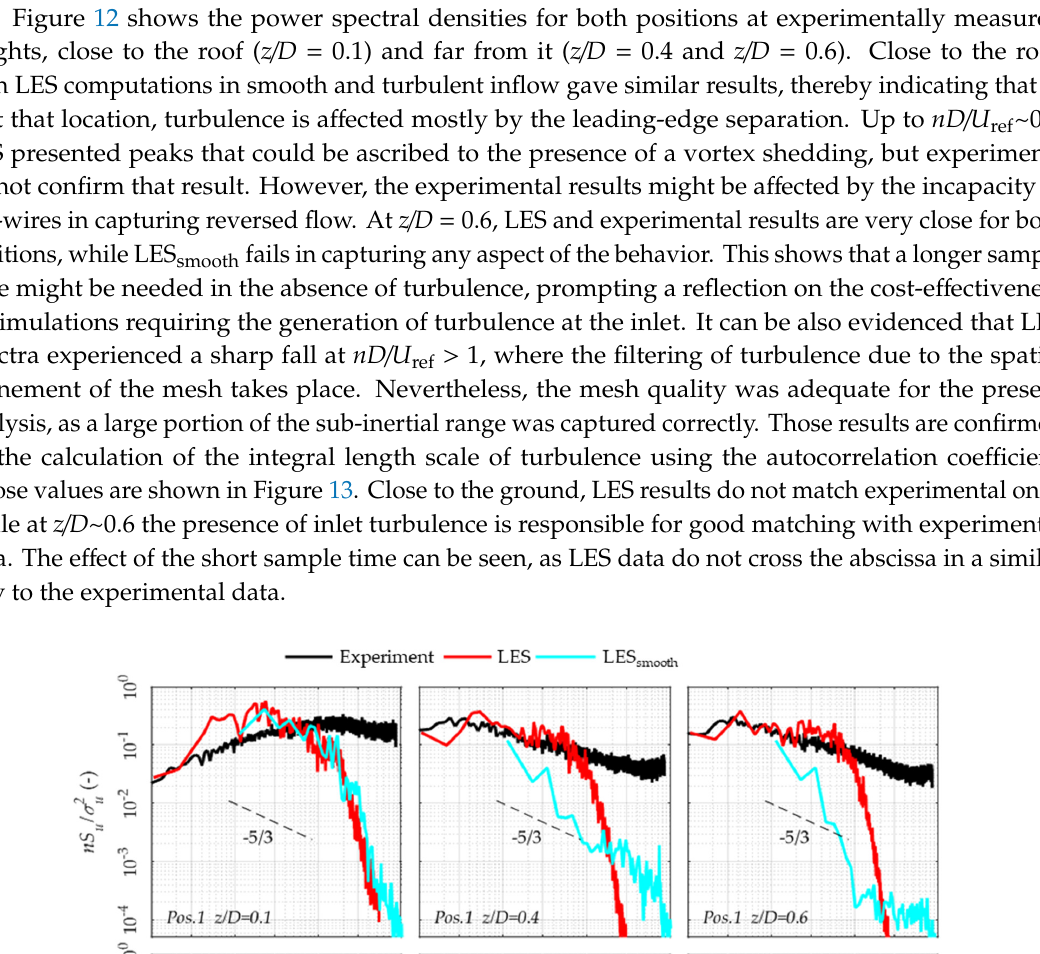
Figure 13. Autocorrelation coefficient for position 1 at two heights, z/D = 0.1 and 0.6. Figure 14 shows the longitudinal integral length scale of turbulence L u /D at roof level positions, which is calculated using the Taylor hypothesis through the integral of the autocorrelation function ρ u up to the first zero-crossing, multiplied by the mean velocity U . The integral length scale shows a steady growth up to a height of z/D ~0.22 at position 1 (0.45 at other positions). At greater heights, L u keeps growing with a different but slower rate up to a maximum point at z/D ~0.55, and hints at a slow decrease for even greater heights z/D > 0.7. At z/D ~0.55 the probe is in a region of the flow with high shear stresses, which might explain the larger length scale measured in the experimental tests and not captured by the numerical solver. Concerning LES smooth , results show that the length scale is greatly overestimated for z/D > 0.2. That outcome is coherent with the very low turbulence intensity shown in Figure 9 for the corresponding calculation. On the contrary, LES results with fluctuating inflow match well with experimental data, especially for position 1. At other positions, LES slightly underestimates the length scale by a factor of about 20%: that might be explained considering the overestimation of the turbulence intensity inside of the separation bubble shown in Figure 9, which might be solved either by improving the mesh refinement in the wind tunnel fetch length or increasing the sample time.